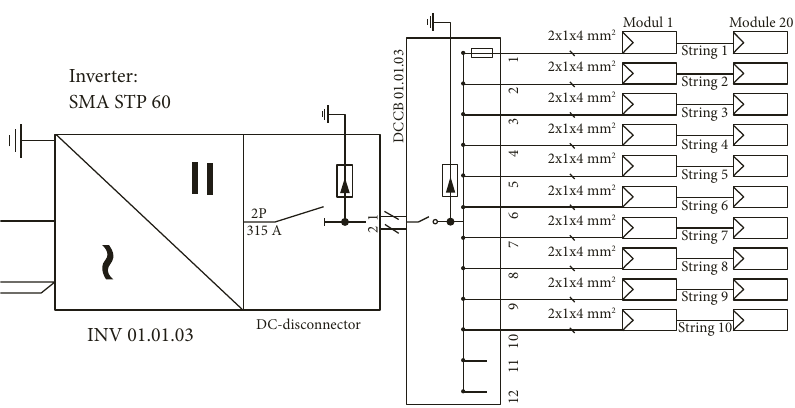
Figure 3: Multistring topology arrays coupled to one inverter.